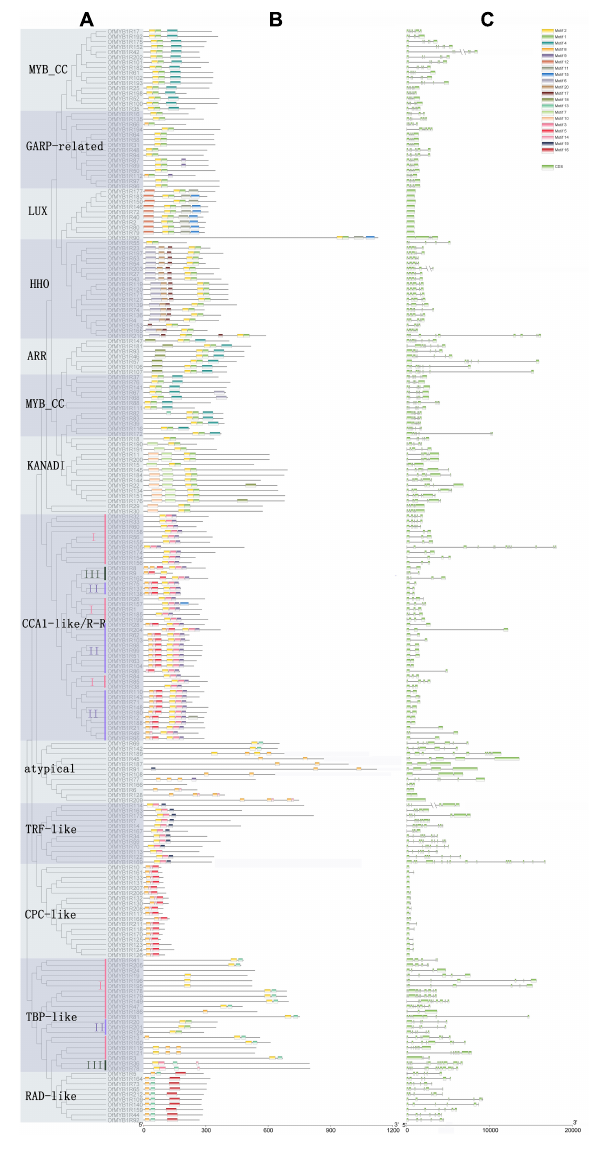
FIGURE 2 | Phylogenetic relationships of 212 OfMYB-related proteins, visualized by a ML tree (A) . Conserved motifs of OfMYB-related proteins (B) . Exon/intron structures of OfMYB-related genes. Exon(s) and intron(s) are shown with green boxes and gray lines, respectively (C) . The 20 conserved motifs in the OfMYB-related TFs were predicted by the MEME Suite web server. I–III indicate clades